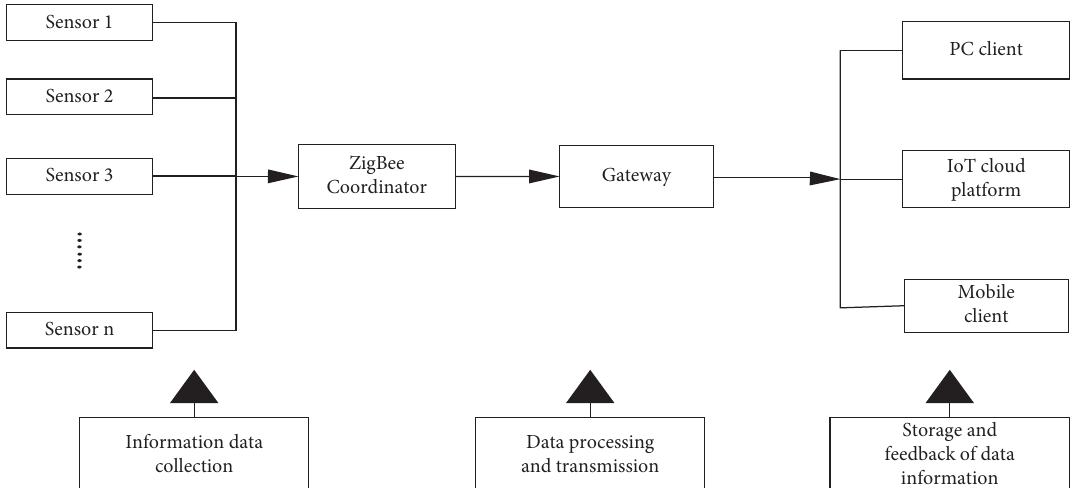
Figure 1: Network architecture model of the Internet of